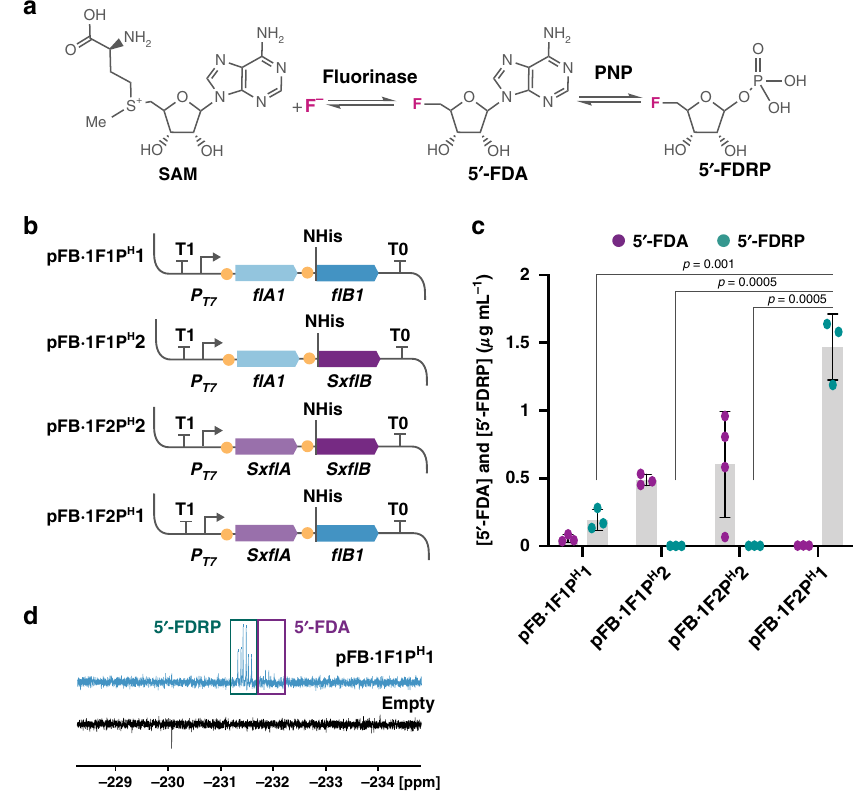
Fig. 4 In vitro biosynthesis of fl uorosugars in cell-free extracts of engineered P . putida . a Fluorination and phosphorylation steps in the canonical bio fl uorination pathway of S. cattleya . In the second step, 5 ′ - fl uoro-5 ′ -deoxyadenosine (5 ′ -FDA) is converted into 5 ′ - fl uoro-5 ′ -deoxy-D-ribose 1-phosphate (5 ′ -FDRP) by PNP (purine nucleoside phosphorylase). b Plasmid constructs of FluoroBricks encoding fl uorinases and PNPs from Streptomyces sp. MA37 ( fl A1 and fl B1 ) or S. xinghaiensis ( Sx fl A and Sx fl B) under control of the P T7 promoter, which is used in combination with the synthetic FRS-T7 RNA